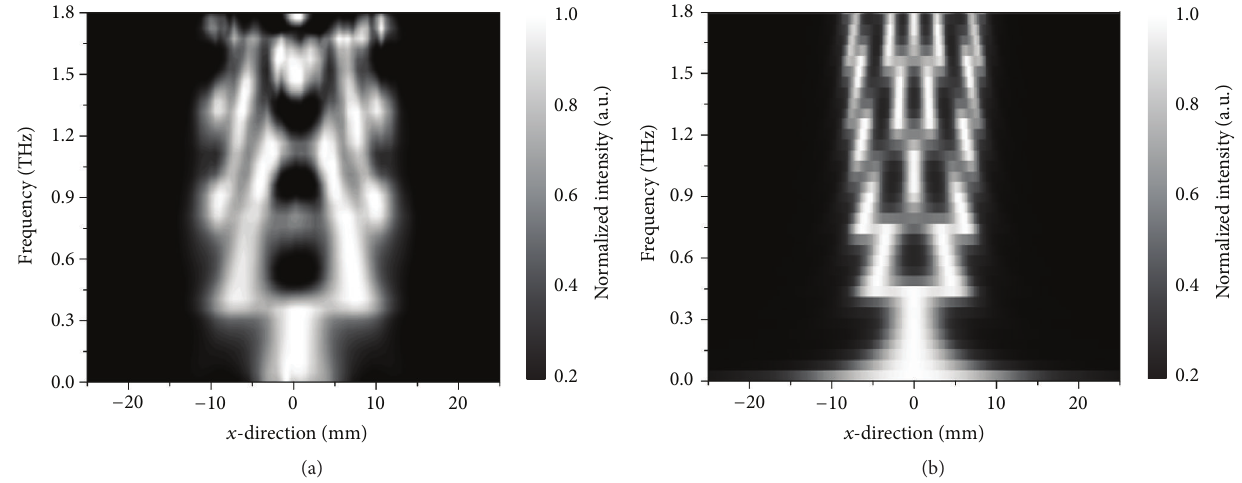
Figure 8: Measurement (a) and simulation (b) of the THz radiation pattern for LT-GaAs on SI-GaAs substrate as emitter at a distance of 65 mm in 𝑧 -direction. Interference minima in both cases are clearly